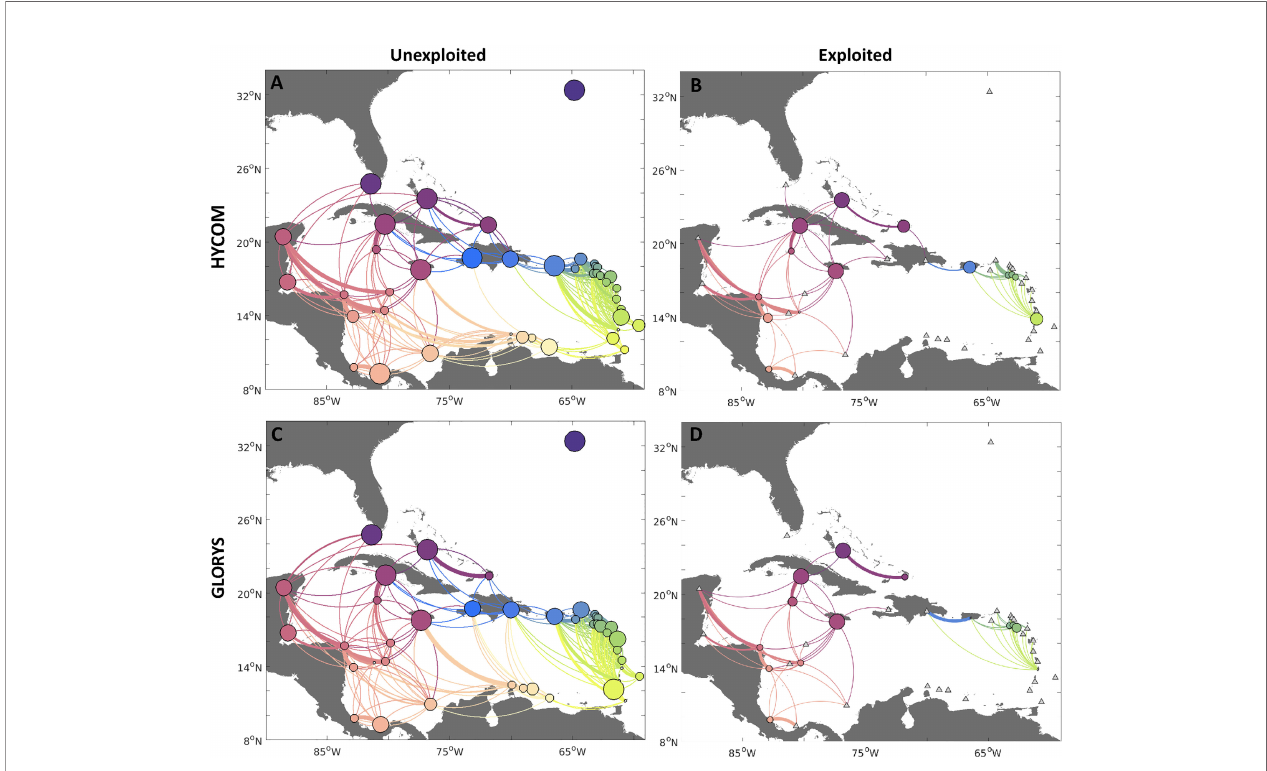
FIGURE 4 | Connectivity networks for queen conch for two different reproductive output scenarios: 1) unexploited, i.e. spawning uniform for each habitat polygon ( A, C left column); and 2) exploited, with spawning scaled by median adult densities reported per jurisdiction ( B, D right column). Larvae were dispersed with HYCOM ( A, B , top row), and GLORYS ( C, D , bottom row) velocities. Edges between nodes represent the strength of connections between sites, whereby the direction of larval fl ow is given by the clockwise direction - concave edges represent export while convex represents import. Node sizes represent the probability of self-settlement. Jurisdictions with no spawning in the exploited density scenario are marked with a triangle. The results for each model were based on 90 releases in the period of fi ve years